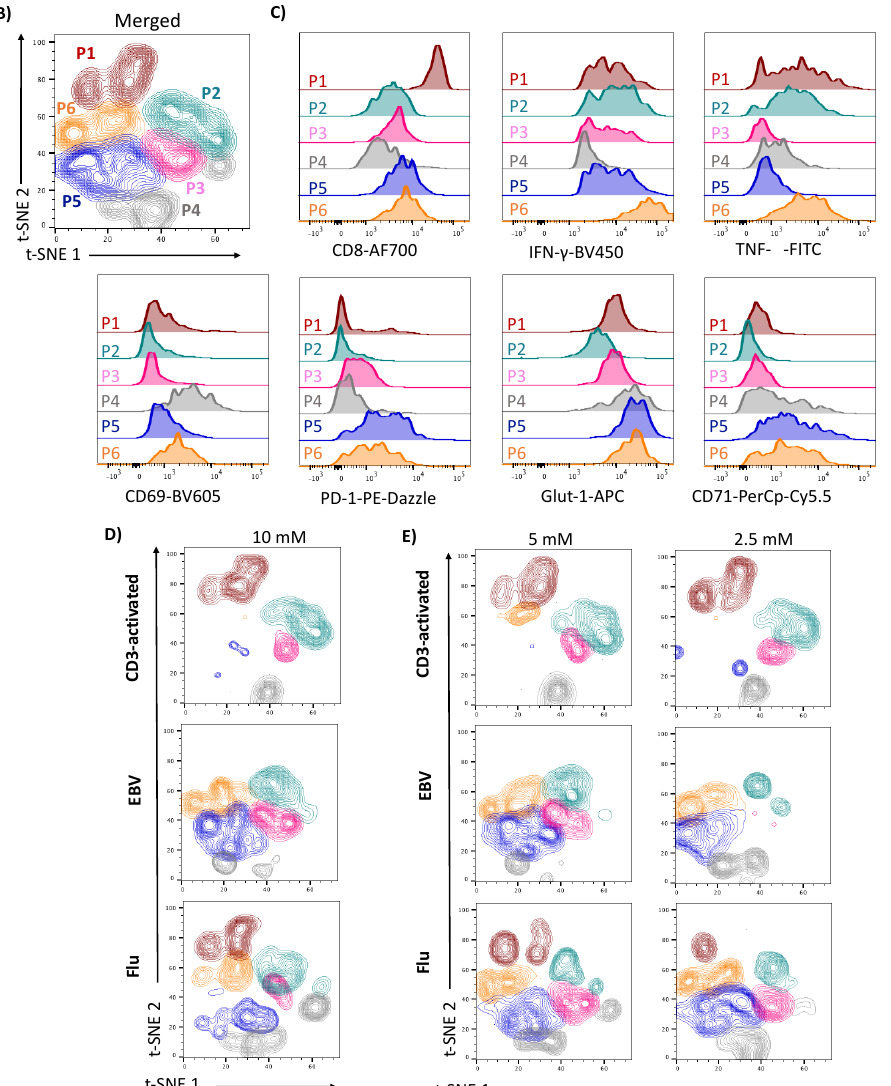
Figure 1. CD3-activated and virus-specific T cells have a di ff erent activation profile. PBMCs were either stimulated overnight with plate-bound anti-CD3, then rested in non-coated wells and restimulated overnight with 1 µ g / mL coated anti-CD3 on day 7 or were stimulated with 0.5 µ g / mL of Epstein–Barr virus (EBV) or flu peptides, cultured for 7 days and restimulated with viral peptides overnight on day 7. All T cells were maintained in media containing IL-2, which was replenished on day 4. Cytokine production and expression of specific surface markers were investigated by flow cytometry on day 8 post restimulation. ( A ) Diagram of the experimental protocol followed. ( B ) t-SNE algorithm was used to distribute responding cells defined as IFN- γ + CD8 + T cells from the anti-CD3, flu and EBV stimulated cells from the same donor in di ff erent populations depending on the expression of specific surface / intracellular markers. ( C ) Histograms that show the expression of specific surface markers and cytokines used to define the following 6 populations of IFN- γ + CD8 + T after overnight restimulation: population 1 (P1) CD8 high IFN- γ high TNF- α high CD69 low / neg PD-1 low / neg Glut1 high CD71 neg , population 2 (P2) CD8 int IFN- γ high TNF- α high CD69 neg PD-1 neg Glut1 int CD71 neg , population 3 (P3) CD8 int IFN- γ int TNF- α neg CD69 neg PD-1 int Glut1 int CD71 neg , population 4 (P4) CD8 low IFN- γ low TNF- α low CD69 high PD-1 low Glut1 high CD71 int , population 5 (P5) CD8 int IFN- γ high TNF- α high CD69 low / neg PD-1 high Glut1 high CD71 high and population 6 (P6) CD8 int IFN- γ high TNF- α high CD69 int PD-1 int Glut1 high CD71 high ( D ) Clusters of populations detected using t-SNE algorithm after di ff erent stimulations in media containing 10 mM and ( E ) 5 and 2.5 mM of